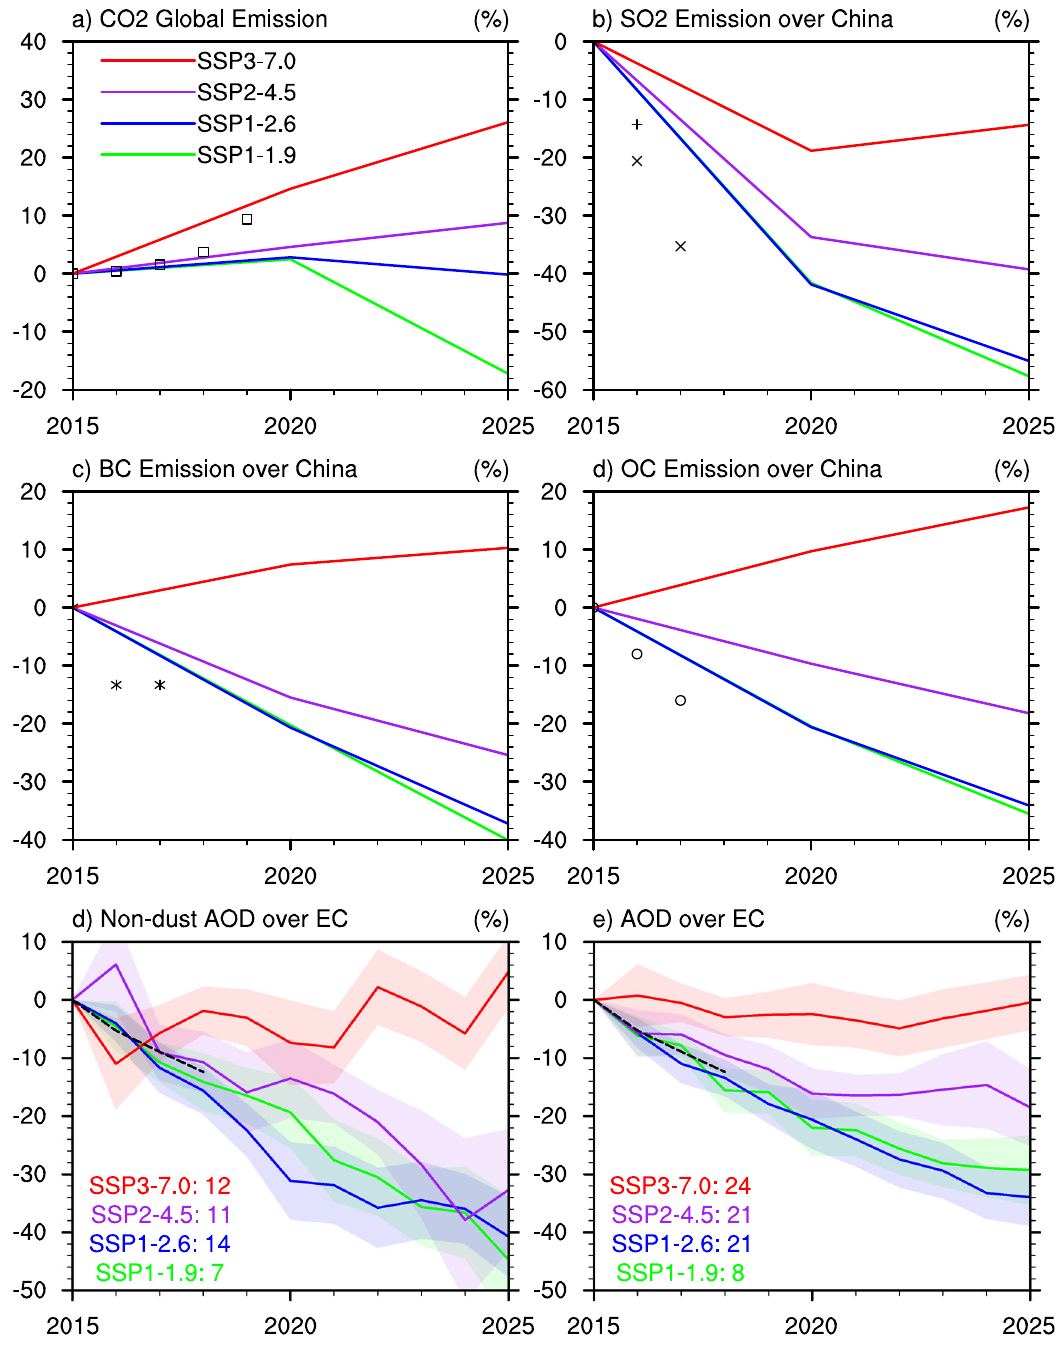
Fig. 5 Relative changes in anthropogenic CO 2 and aerosol emissions, and AODs after 2015. All values are relative to 2015. a Changes in global annual CO 2 emissions under the four SSPs (starting from 2015) (units: %). The boxes are the historical CO 2 emission reported by Friedlingstein et al. 48 . b – d Changes in annual SO 2 , BC, and OC emissions over China under the four SSPs (units: %). The forks are the observation-based changes in SO 2 emissions reported by Li et al. 19 , and the crosses, asterisks, and circle are changes in SO 2 , BC, and OC emissions reported by Zheng et al. 27 and Zhang et al. 12 e , f Changes (units: %) in annual mean AOD over EC from the average of MODIS, MISR, and MERRA-2 (dotted line) and AOD over EC (for non-dust and total, separately) from models under four SSPs. Shadings represent variance within models, and numbers represent the numbers of models